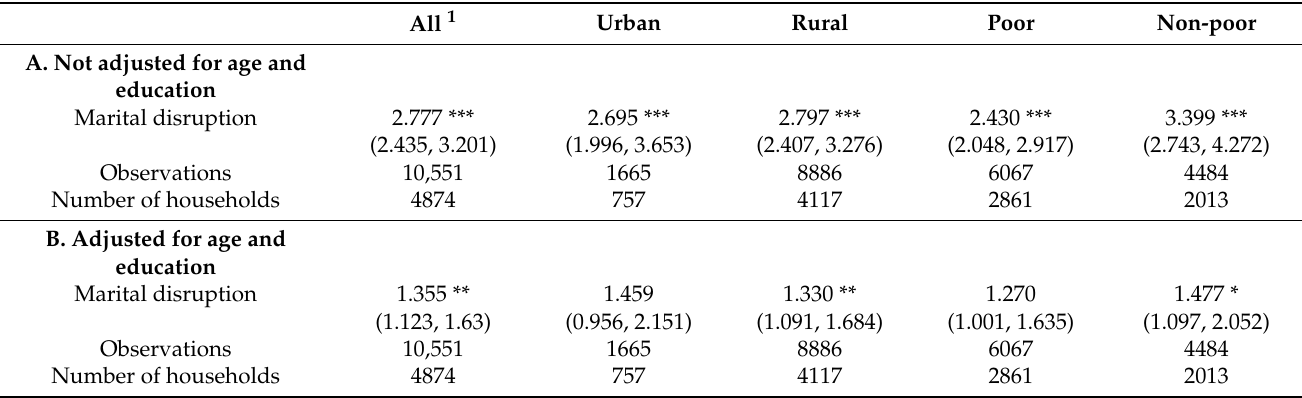
Table 5. Results of conditional fixed effects logistic regression models. All 1 Urban Rural Poor